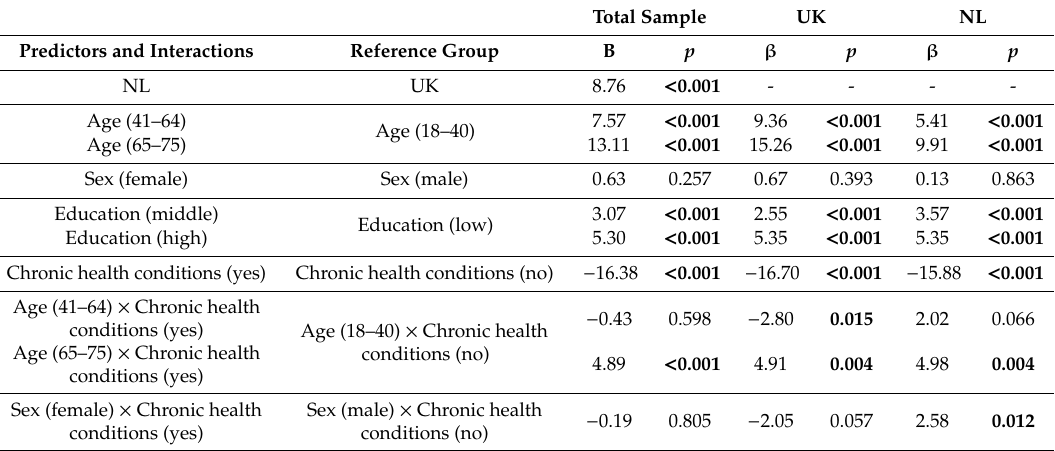
Table 2. Results of the multiple regression analyses (total sample, UK, and the NL). Total Sample UK